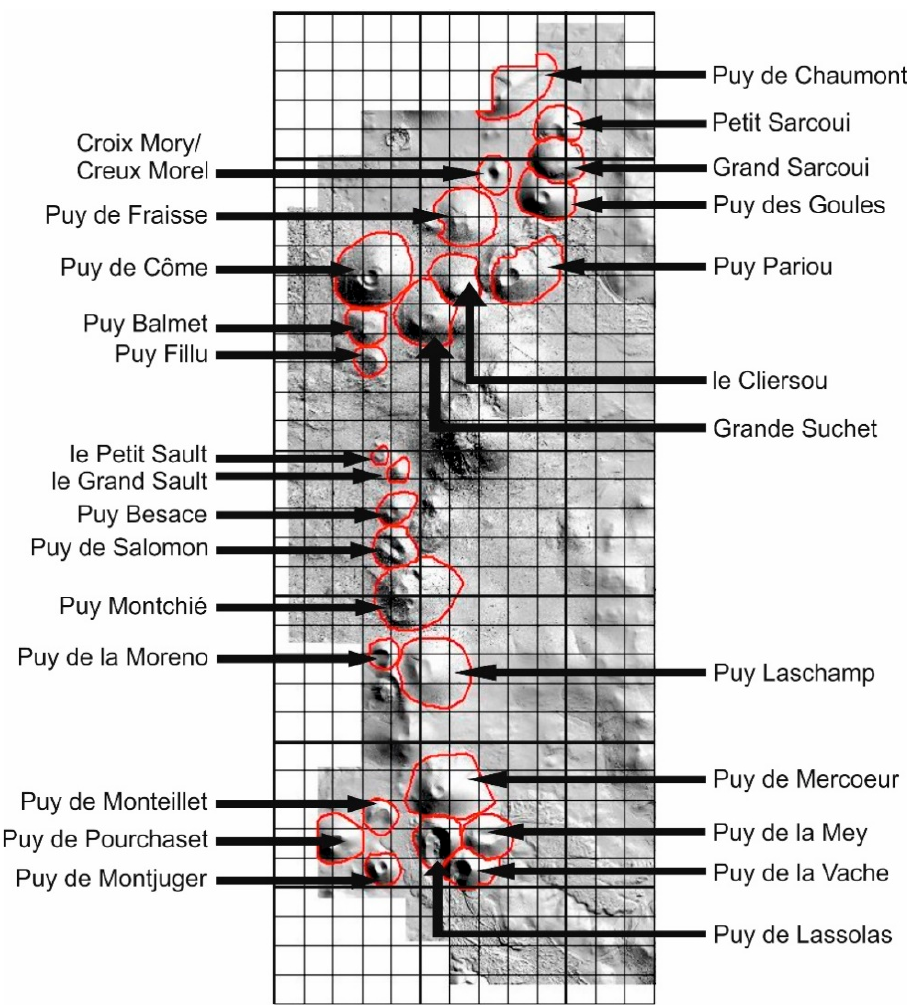
Figure 4. Shaded Light Detection and Ranging (LiDAR) digital terrain models (DTM) of the study are shown with the 500 m × 500 m data grid (described in Section 2.6). Thematic data were determined for every cell. Source of the DTM: [34]. Red outlines are indicating the extents of the studied scoria cones.